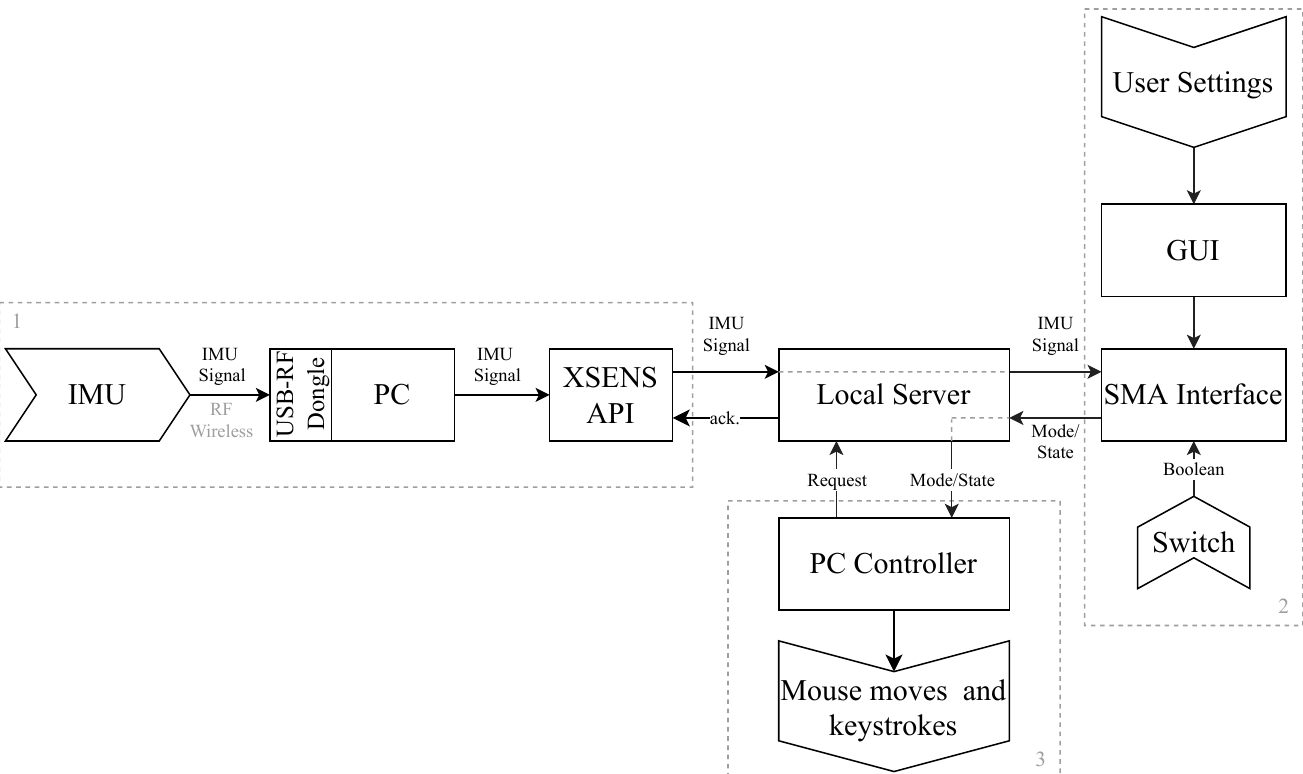
Figure 9. System architecture for implementing an SMA interface for the control of a computer mouse and keyboard. The dotted boxes represent the modular parts of the system. The chevron-shaped boxes represent the inputs and outputs of the